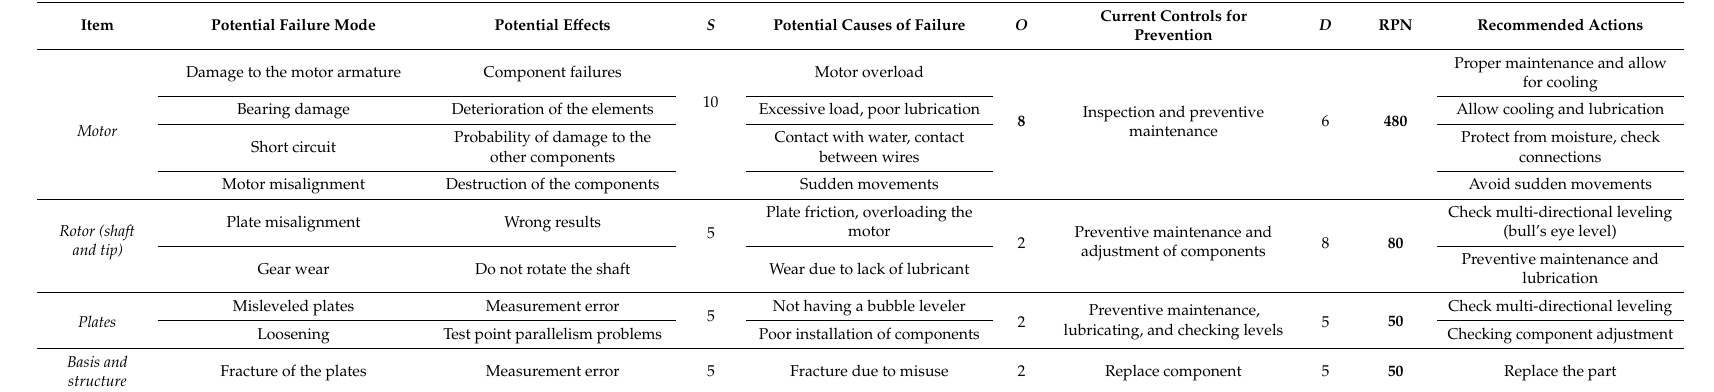
Table 5. Failure Mode and E ff ect Analysis (FMEA)—low-cost rheometer: mechanical components.